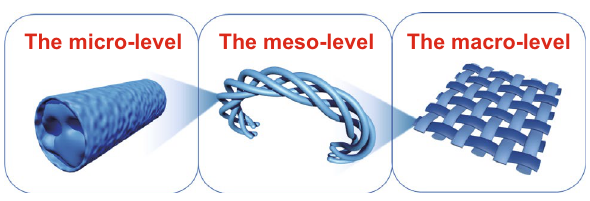
Fig. 2 The figure shows the source of flexibility from three aspects: The micro-level (i.e., porous structure), meso-level (i.e., kink struc- ture), and macro-level (i.e., entanglement